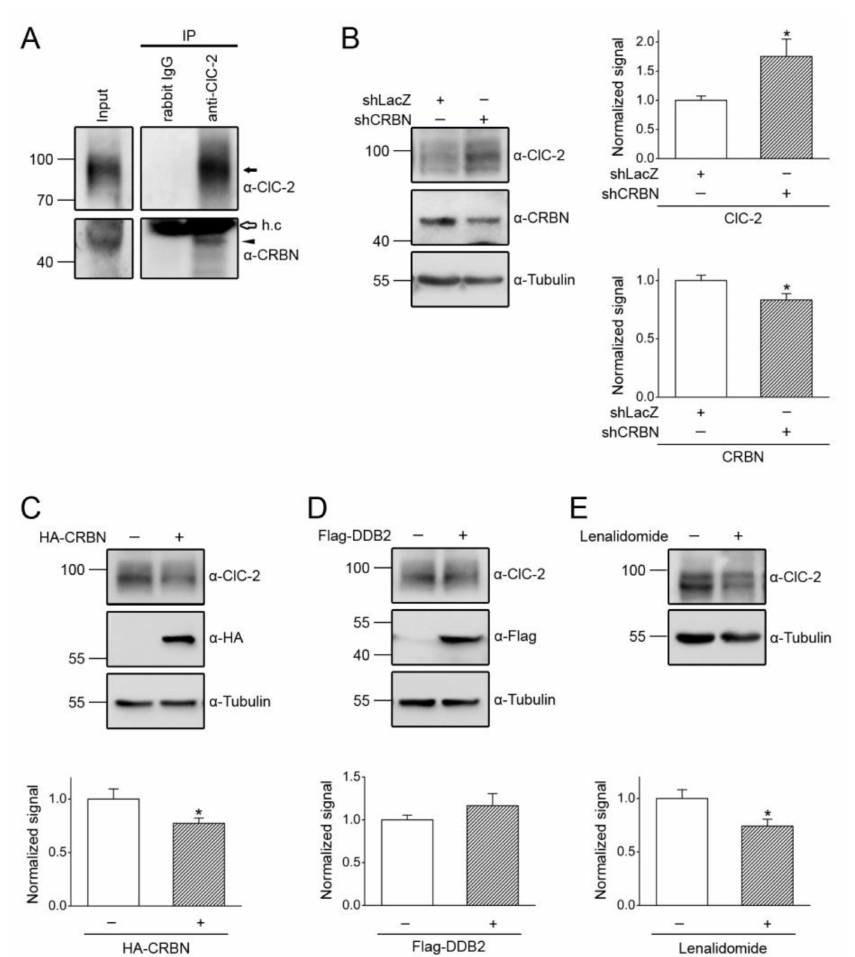
Figure 7. CRBN promotes degradation of endogenous ClC-2. ( A ) Co-immunoprecipitation of endogenous CRBN and ClC-2 in the mouse testis. Mouse testis lysates were immunoprecipitated with α -ClC-2 or the rabbit IgG. The protein bands corresponding to endogenous ClC-2 and CRBN are highlighted with the black arrow and the black arrowhead, respectively. The open arrow denotes the IgG heavy chain (h.c.). ( B ) ( Left panel ) Representative immunoblot showing the e ff ect of shRNA knockdown of CRBN (shCRBN) on endogenous ClC-2 expression in the mouse MA-10 Leydig cell. Infection with shLacZ was used as the control experiment. ( Right panels ) Quantification of relative ClC-2 and CRBN protein levels. Protein density was standardized as the ratio of the ClC-2 signal to the cognate tubulin signal. Values from the shCRBN groups ( hatched bars ) were then normalized to those for the corresponding shLacZ control ( clear bar ). Asterisk denotes a significant di ff erence from the control (*, t test: p < 0.05; n = 7). ( C ) ( Upper panel ) Representative immunoblot showing the e ff ect of HA-CRBN overexpression on endogenous ClC-2 expression in MA-10 cells. Co-expression with the HA vector was used as the control experiment. ( Lower panel ) Quantification of relative ClC-2 protein levels (*, t test: p < 0.05; n = 7). ( D ) ( Upper panel ) Representative immunoblot showing the lack of an e ff ect of Flag-DDB2 overexpression on endogenous ClC-2 expression in MA-10 cells. Co-expression with the Flag vector was used as the control experiment. ( Lower panel ) Quantification of relative ClC-2 protein levels ( t test: p > 0.05; n = 9). ( E ) ( Upper panel ) Representative immunoblot showing the e ff ect of the 24-h treatment of 10 µ M lenalidomide (in 0.1% DMSO) on endogenous ClC-2 expression in MA-10 cells. ( Lower panel ) Quantification of relative ClC-2 protein levels (*, t test: p < 0.05; n =